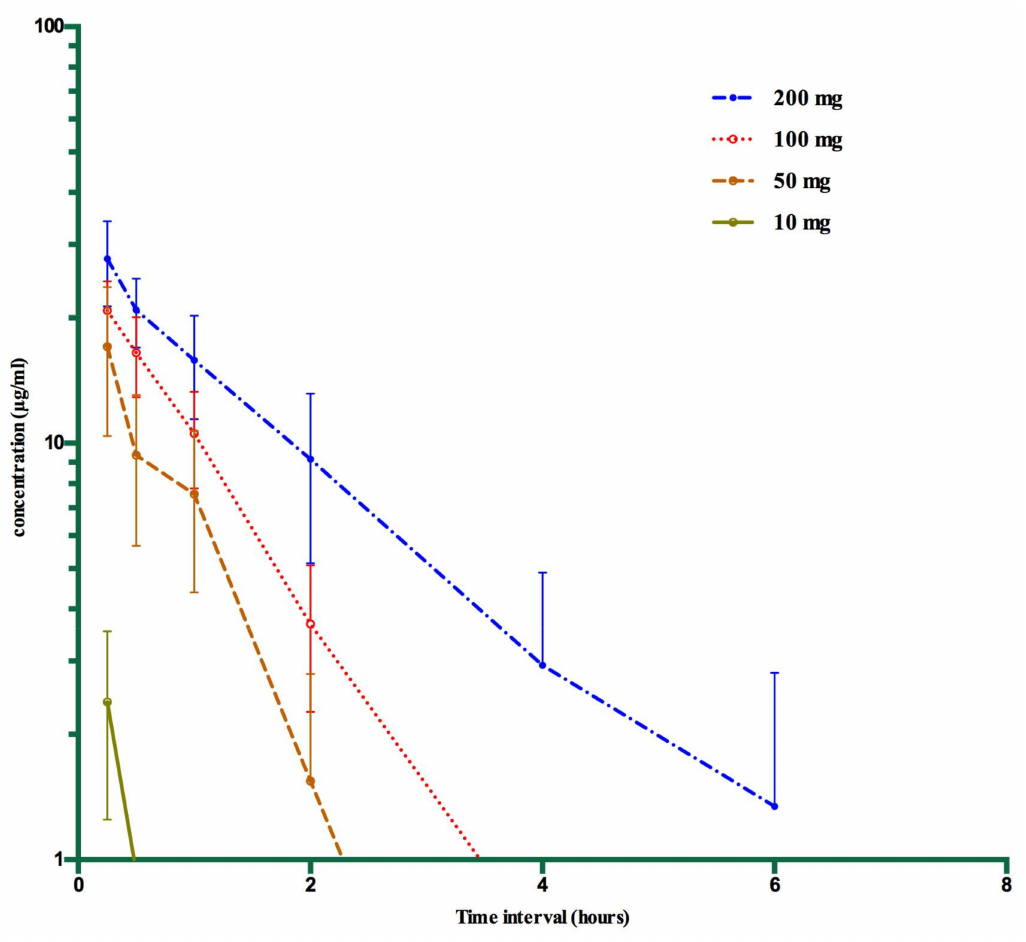
Figure 2. Semi-log concentration–time curve for salicylic acid after all treatments (10, 50, 100, 200 mg/kg) of IV SS in six sheep (mean ±